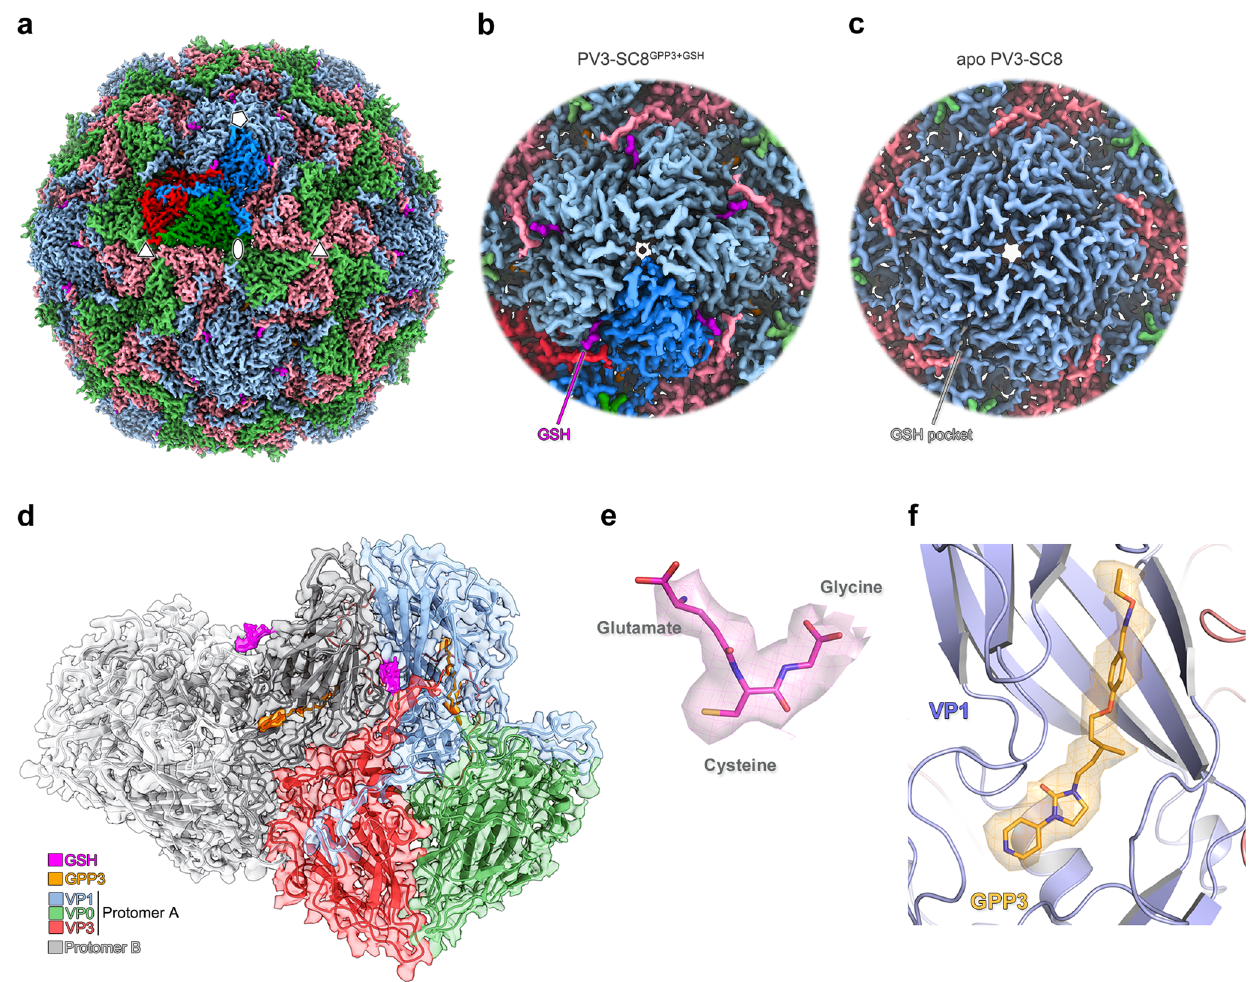
Fig. 1 Cryo-EM structure of the PV3-SC8 GPP3 + GSH complex. a Three-dimensional reconstruction of PV3-SC8 VLP after incubation with a molar excess of GSH and GPP3. The VLP is viewed along the icosahedral twofold symmetry axis with the VP1, VP0 and VP3 subunits of the capsid protomer coloured light blue, light green and light red, respectively. A single capsid protomer is coloured in a darker shade, GSH magenta and GPP3 orange. b Close-up view looking down the icosahedral fi vefold symmetry axis, coloured as in a showing GSH bound at an interprotomer interface. c Close-up view along the fi vefold axis of the apo PV3-SC8 VLP reconstruction (EMD-15543) showing the absence of features for GSH. d Cartoon representation of two neighbouring capsid protomers; protomer A is coloured as in a , protomer B is coloured grey, GSH magenta and GPP3 orange. The cryo-EM map is depicted as a semi- transparent surface. e Cryo-EM electron potential map with GSH fi tted as a stick model and elemental colouring for oxygen (red), nitrogen (blue) and sulfur (yellow). The map is displayed at a contour level of 1.2 σ ( σ is the standard deviation of the electron potential map). f Cartoon depiction of the VP1 hydrophobic pocket with bound GPP3 fi tted into the cryo-EM potential map. The electron potential map for GPP3 is shown at 1.5 σ . All electron potential map images are rendered at a radius of 2 Å around